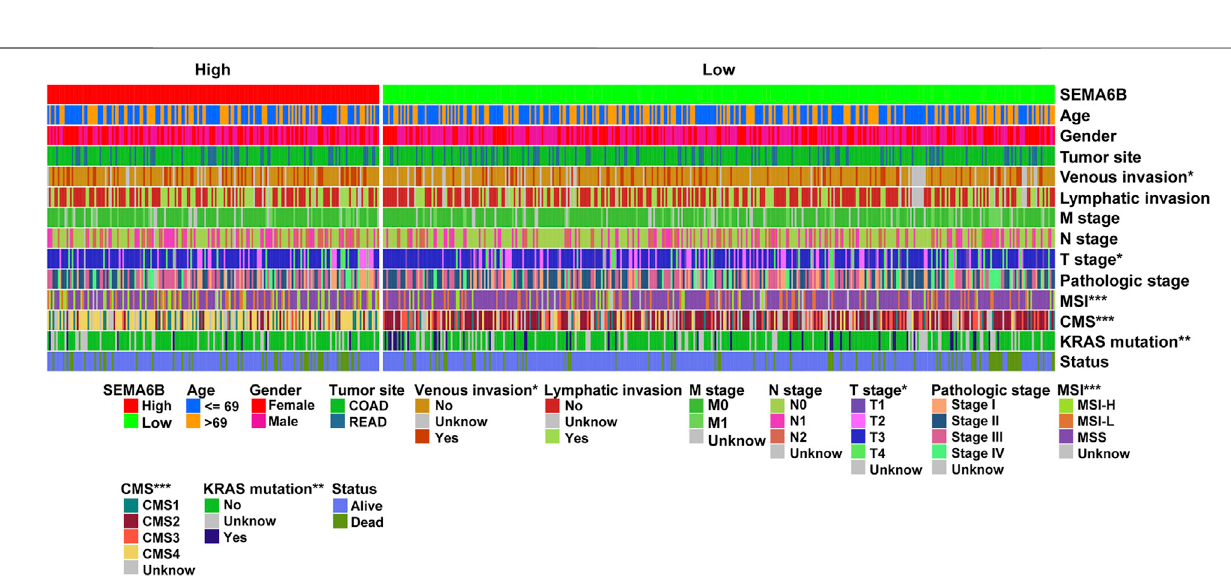
Frontiers in Molecular Biosciences |